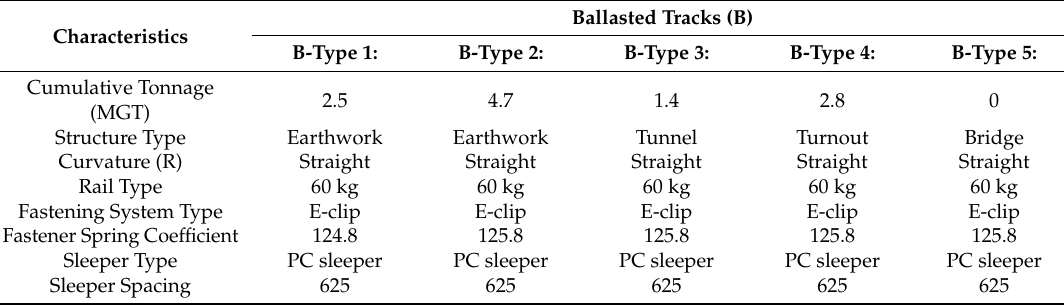
Table 2. Track specifications (ballasted tracks) .